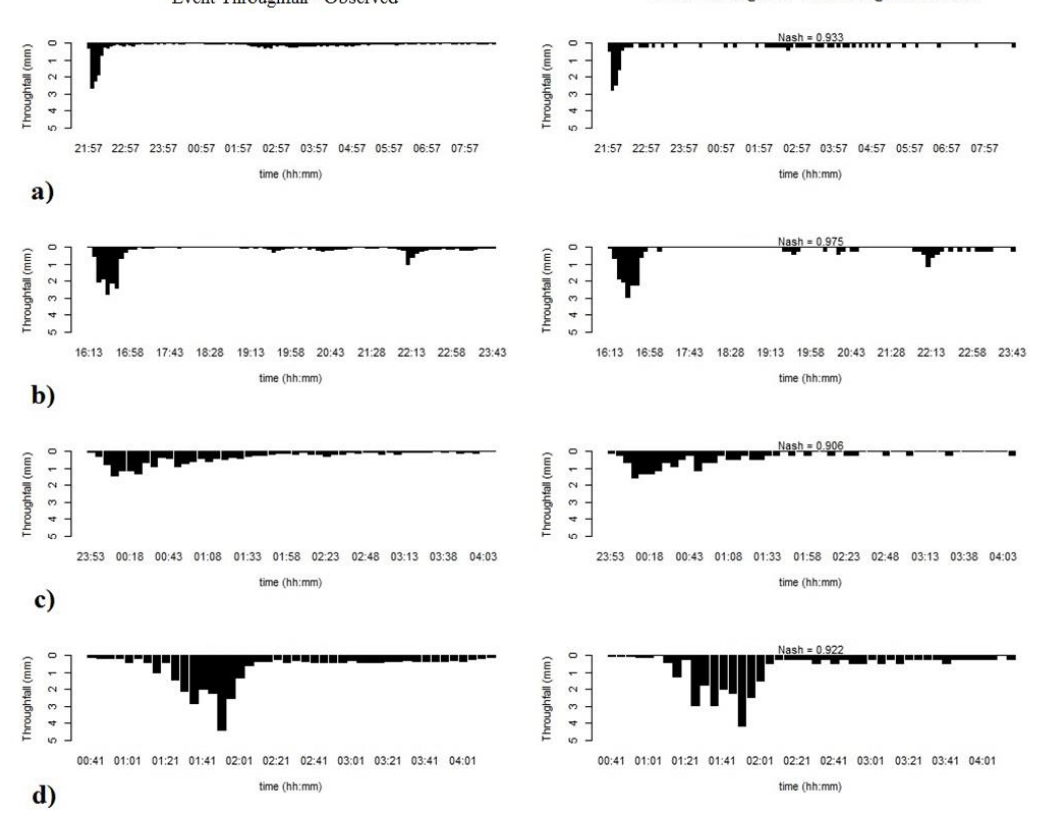
Figure 11. Some throughfall simulation results from PSO / Image-based parameterization. ( a ) event 1; ( b ) event 2, ( c ) event 10, ( d ) event 21.